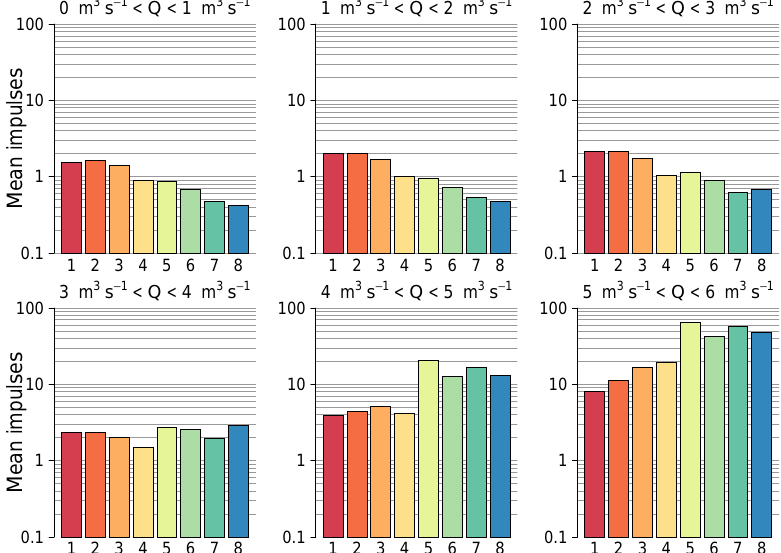
Figure 13. Fischbach: arithmetic mean of geophone impulses per 15min for each of the eight plates (ordinates), averaged over the period 2008–2013 and including zero values, for discharge Q classes with width of 1m 3 s − 1 , for discharges up to 6m 3 s − 1